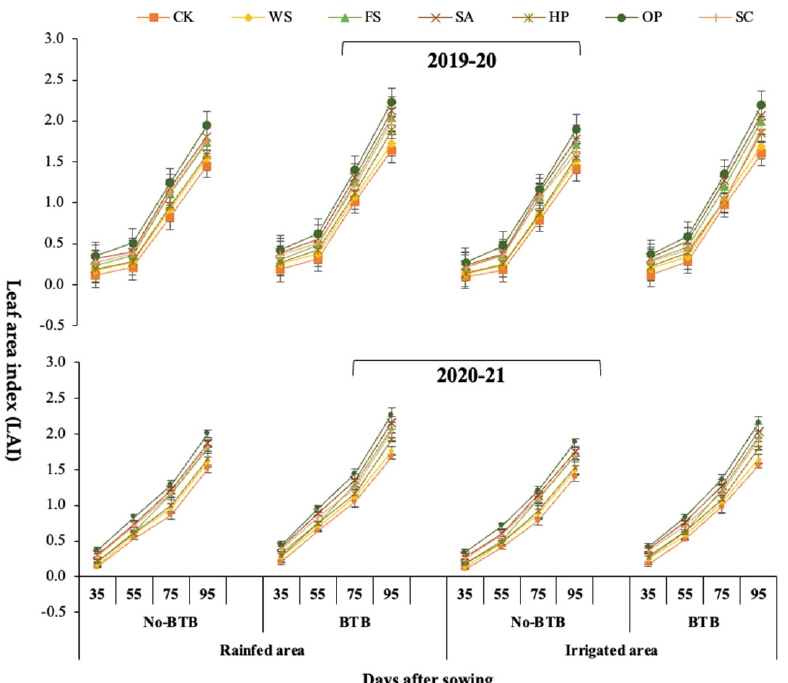
Figure 2. The impact of different boron application methods and boron ‐ tolerant bacteria ( Bacillus sp. MN54) on leaf area index of desi chickpea grown under rainfed and irrigated conditions. Here: CK = control; WS = water spray; FS = foliar spray of B; SA = soil application of B; HP = hydropriming; P = osmopriming of B; SC = seed coating of B; and BTB = boron ‐ tolerant bacteria.